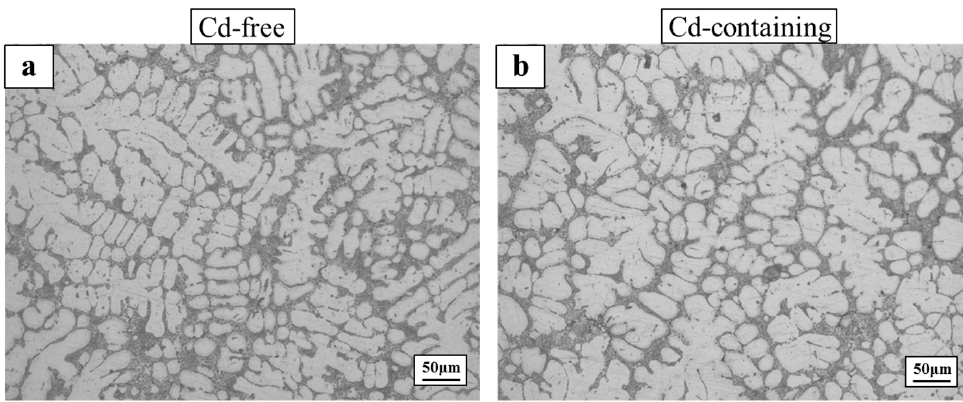
Figure 1. As-cast microstructure and metallographic images of the alloy: ( a ) Cd-free and ( b ) Cd-containing.